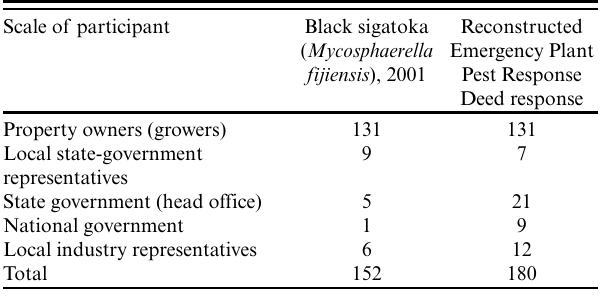
Table 1 . Number of participants across all committees and working